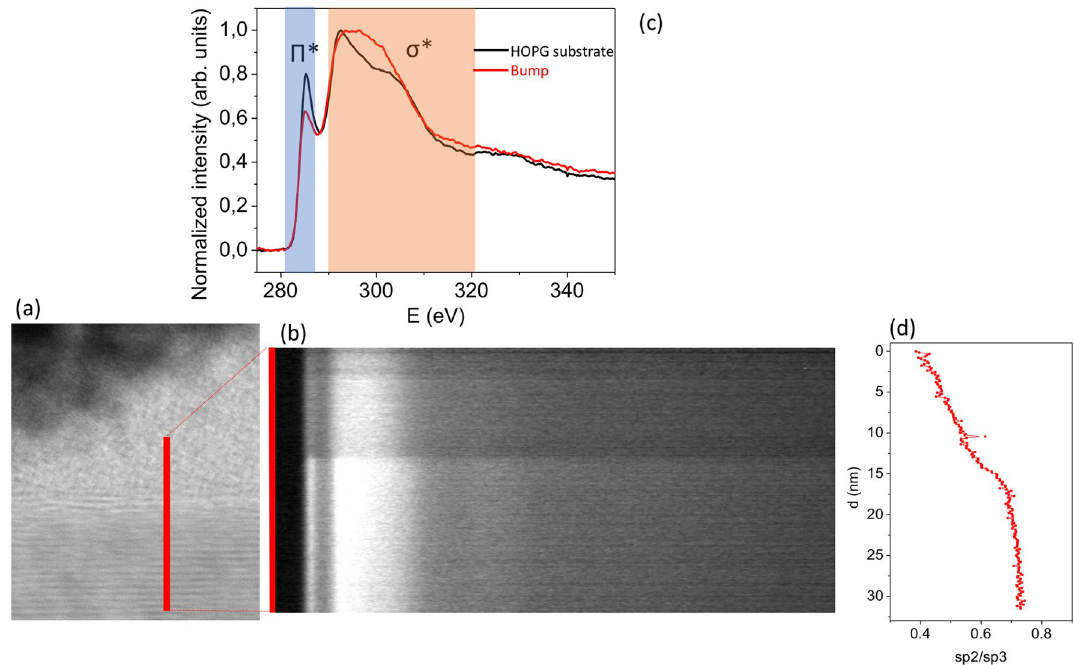
Figure 3. Electron energy loss spectra (EELS) of the UV processed HOPG: ( a ) Location of the slit on the material, ( b ) long-slit spectra, ( c ) averaged spectra in the HOPG substrate and in the bump. In ( c ) the location of the spectral signature of graphite’s Π* bond is marked. Note that the Π* bond signature is weaker in the bump but still present, meaning that the bump is not pure diamond. The ratio of the signal in the Π* and σ* spectral bands ( c ) is used to define the sp 2 /sp 3 index that it is displayed in ( d ). The signal in the Π* spectral band is minimal on the surface and increases